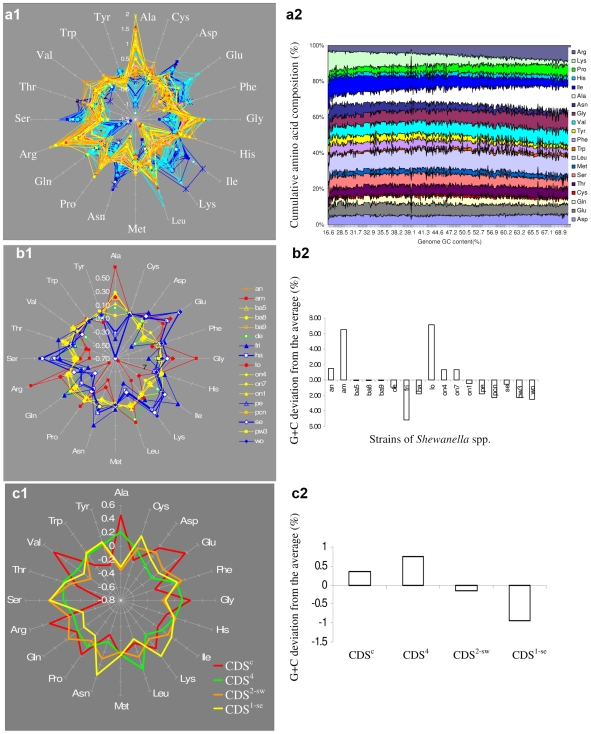
The characteristic profiles of amino acid composition and G+C content in cold-adapted γ-proteobacteria.Bacterial abbreviations for b1, b2 are listed in Table 1. In general in a1,b1,c1, each axis represents the deviation of one amino acid composition in one bacterium (or CDS set) from the average in all bacteria compared. One line shows the amino acid deviation in one specific bacterium or CDS set. a1, deviation in one bacterium from the average of all 118 proteobacteria as given in Fig 2; b1, deviation in one strain of Shewanella from the average of 17 strains of Shewanella; c1, deviation in one set of CDS from the average of total CDSs in S. sediminis. Warm-adapted bacteria were represented by yellow, orange and red lines and symbols; cold-adapted bacteria were represented by the blue lines and symbols. a2, correlation between amino acid compositions of all 623 sequenced bacteria and their G+C content. Bacteria are represented by their G+C content. Amino acid compositions are displayed in a cumulative format. b2, deviation of G+C content in one strain of Shewanella from the average of all 17 strains of Shewanella; c2, deviation of G+C content of a set of CDS from the value of total CDS in S. sediminis. In a1, b1, blue curve indicates the psychrophilic (or psychrotrophic) bacteria; yellow, orange, and green curves indicate bacteria living in warm environments.